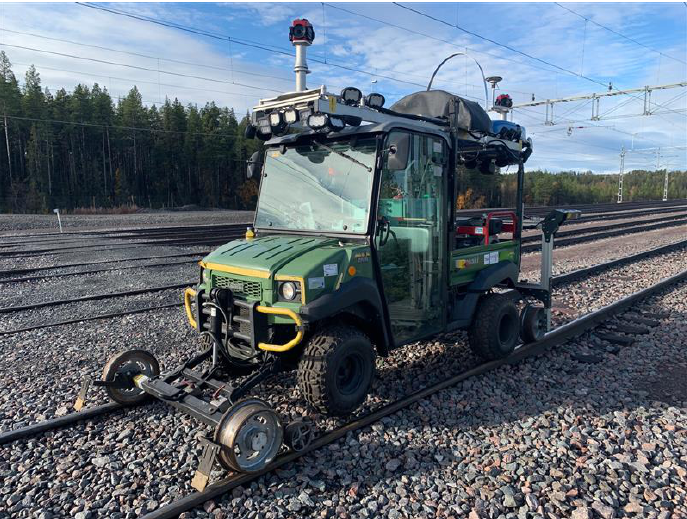
Figure 6. Mobile mapping system for tunnel inspections developed by the company WSP